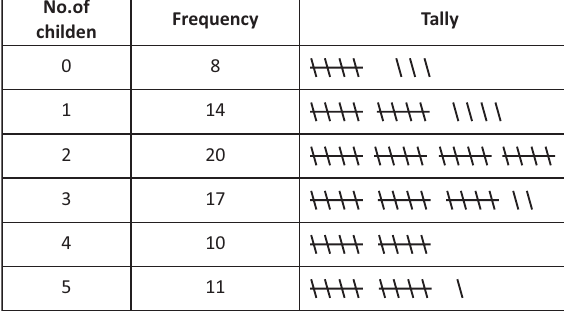
FIGURE 6: Frequency table for the number of children in different households.